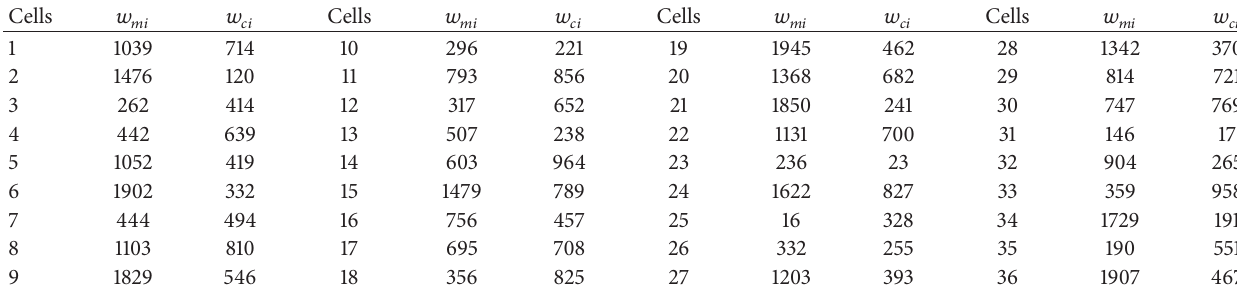
Table 3: Cells attribute for the 6 × 6 test network.